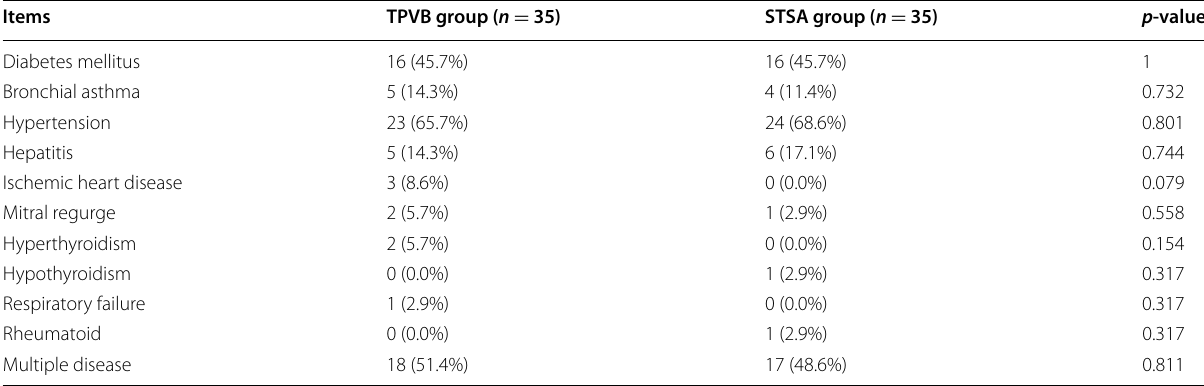
Data are expressed as number ( n ) and percentage (%)